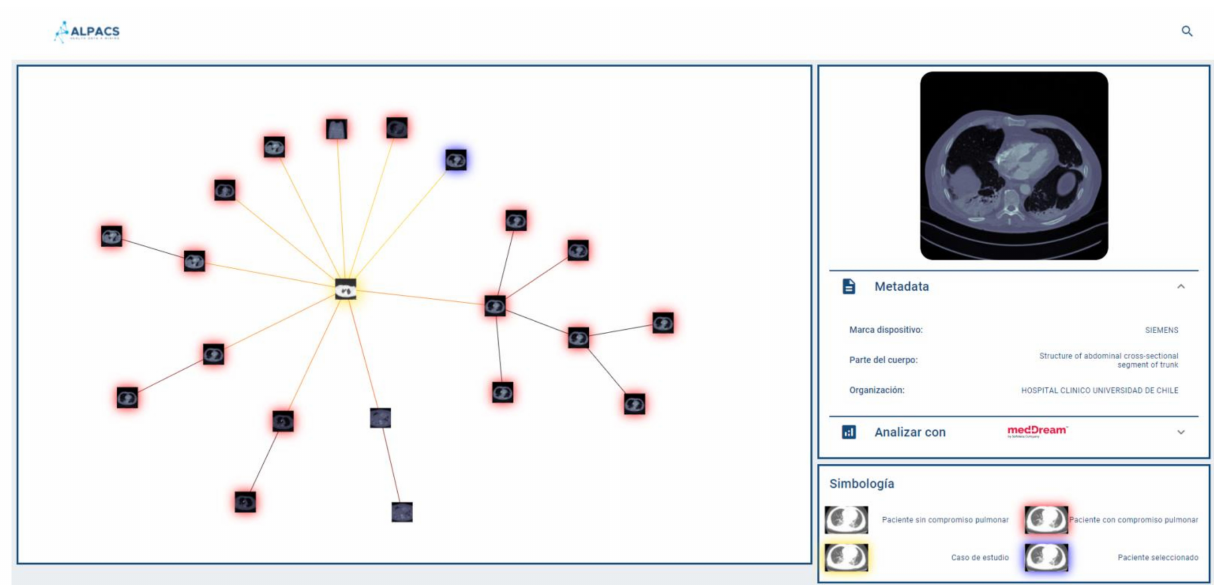
Figure 3. A new image is used to formulate a query. The user has the option to also include a diagnosis or other keywords. The query engine displays nearest neighbors’ graph (with and without pulmonary findings shown with red halo and without colored halo, respectively) centered around the query image (yellow). The user can select an image from the graph, which displays the image’s metadata tab, if the metadata is available. The system is currently available in Spanish ( marca dispositivo , device brand; parte del cuerpo , body part; organizaci ó n , organization; simbolog í a ,